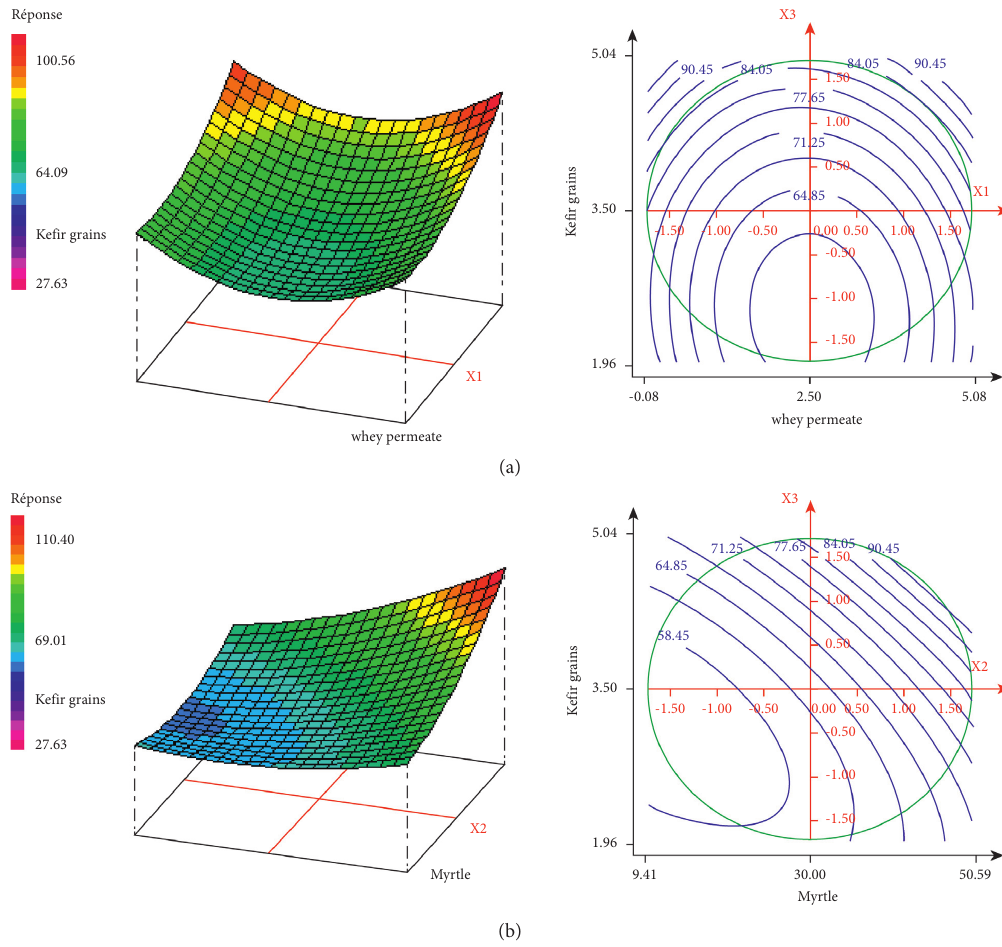
Figure 2: Response surface and contour plots representing the effect of WP and KG (a) and the effect of MJ and KG (b) on total polyphenol content ( X 1 : WP (% w/v); X 2 : MJ (% w/v); and X 3 : KG (% w/v)).